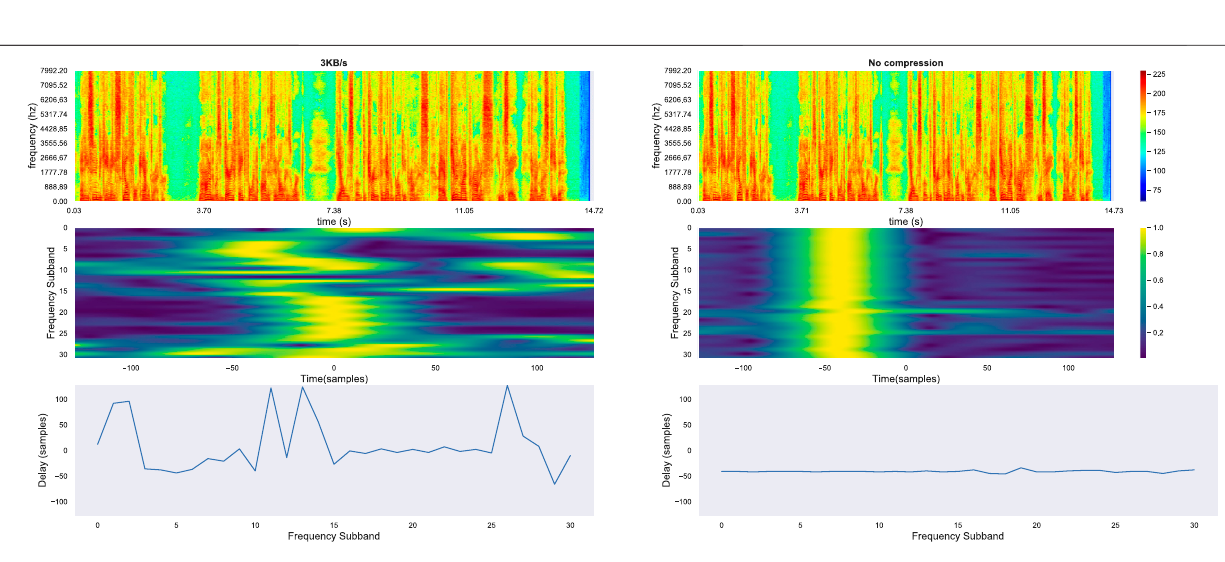
FIGURE 12 | 1 st row: Spectrograms for one uncompressed test utterance channel and its Lyra-encoded versions at very low bitrate 3 kB/s. 2 nd row: Frequency- slidedCPSinputfeature computed betweentwosegmentsoftheencodedchannels. 3 rd row:argumentofthemaximumofCPS ineachfrequencybandcorresponding to the delay (samples) between the two